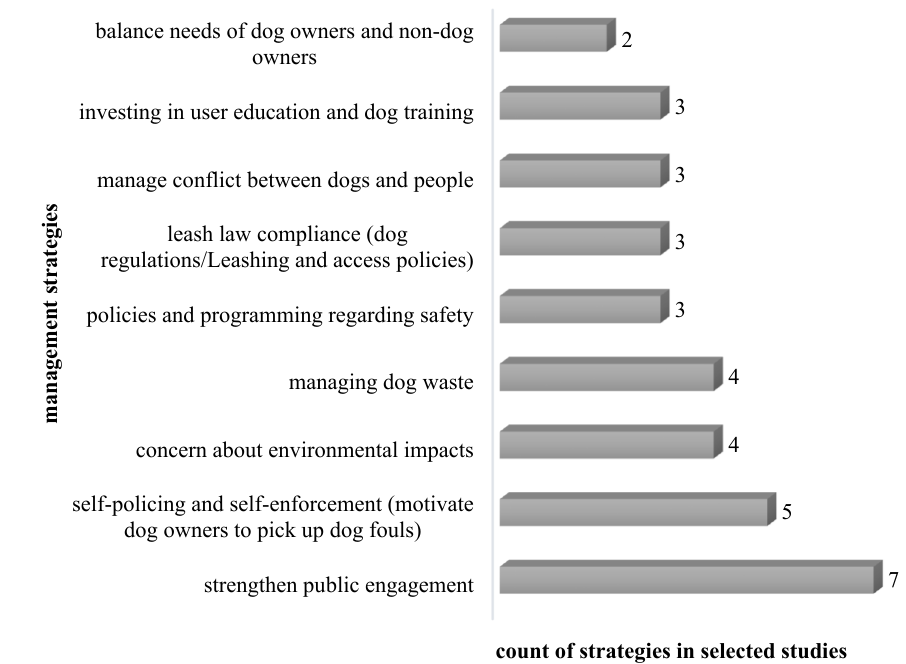
Figure 7. Count of strategies in studies summarizing the management strategies for dog parks.